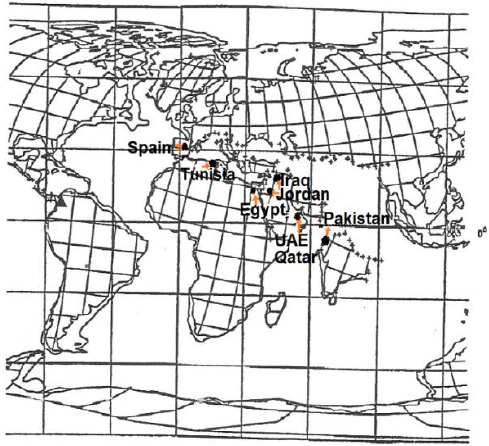
Figure 5: The Early Paleogene paleogeographic map of the Tethys: Spain, Tunisia, Egypt, Jordan, Iraq, UAE, Qatar, Pakistan (Smith et al,